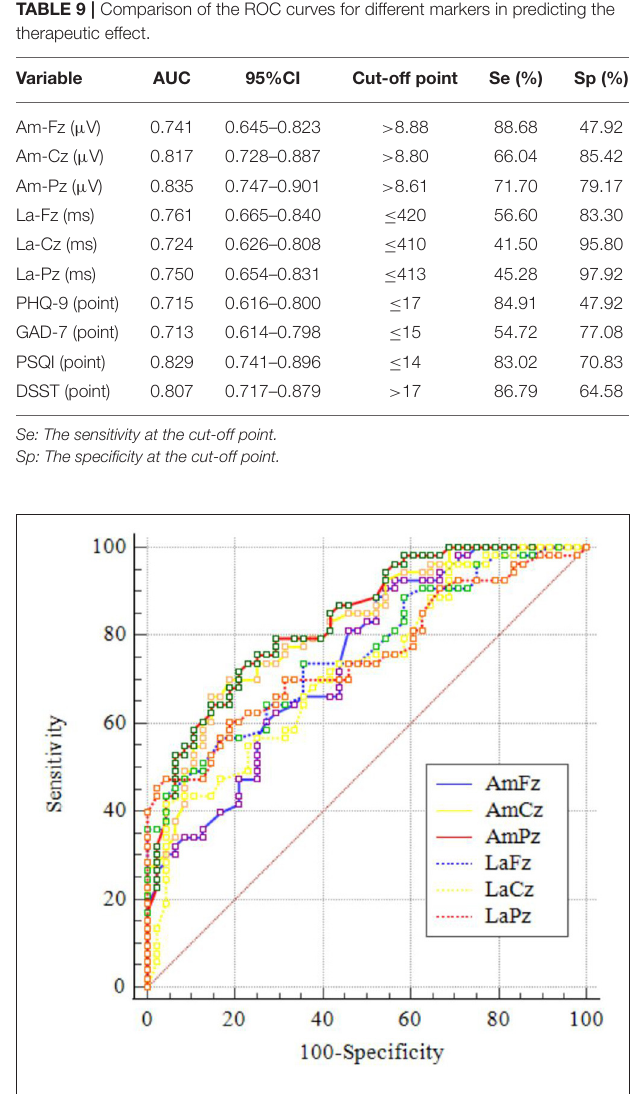
FIGURE 2 | ROC curves of the ERP data in predicting the therapeutic effect.